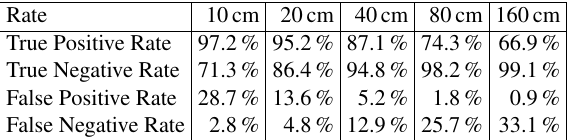
Table 2. The rates of correct classification, type I and type II